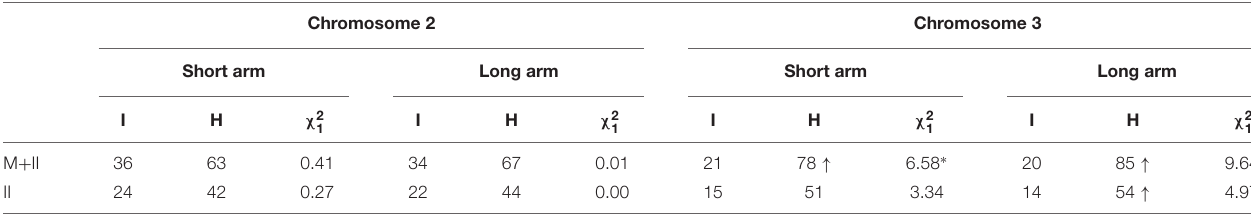
TABLE 4 | Number of Col/L er 4x chromosome configurations with at least one chiasma between identical (I) or homologous (H) chromosomes in bivalent pairs (II) and multivalents + bivalent pairs (M + II) and the goodness of fit to the expected ratio